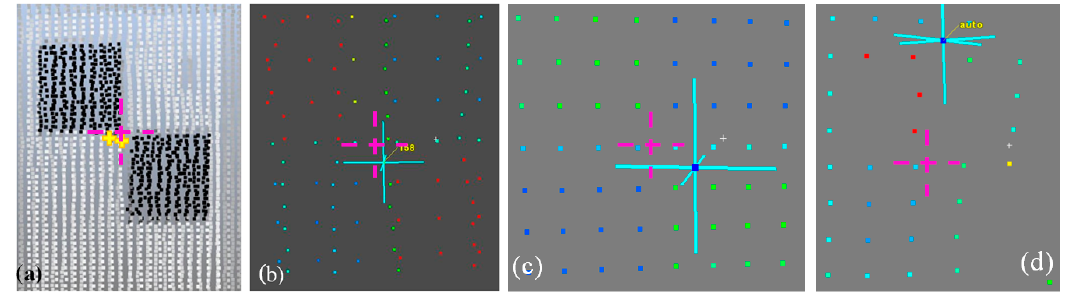
Figure 1. Identification of the target centre ( a ) automatically (yellow crosses) on two different dense point clouds; ( b ) the manual identification of the centre in a sparse point cloud; ( c ) and ( d ) erroneous centre autodetection. Fuchsia crosses indicate theoretical target centre.